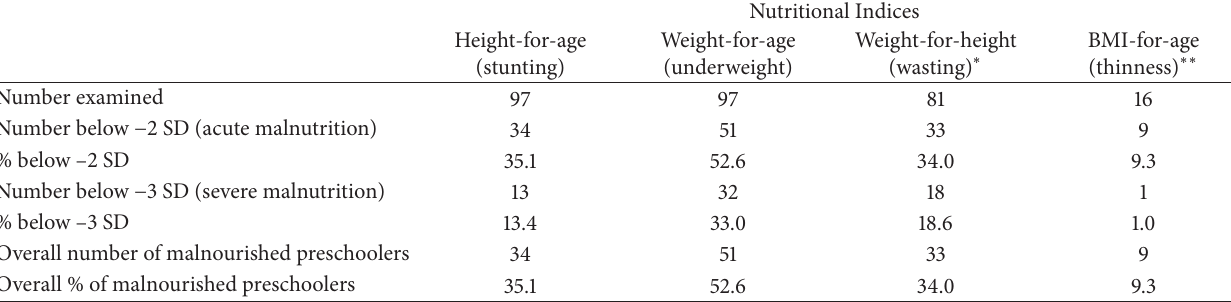
Table 5: Nutritional indices ( 𝑍 -score) of the surveyed preschool aged children.